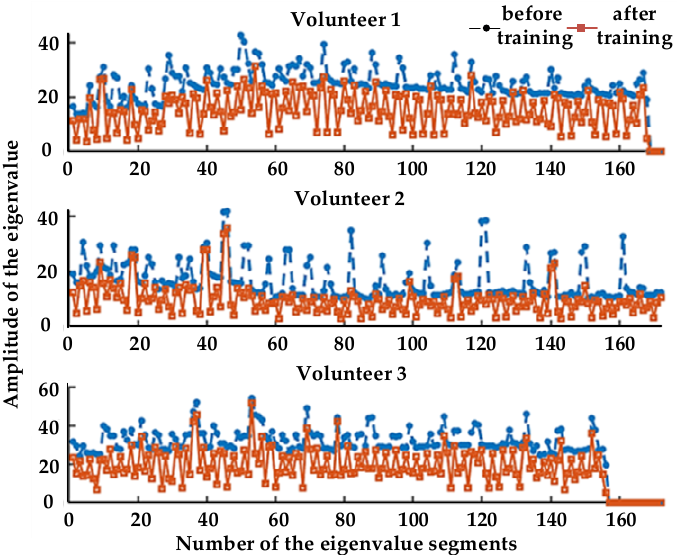
Figure 19. Changes in RMS.